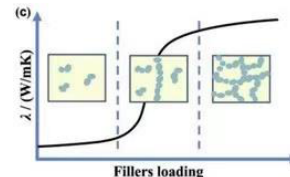
Figure 1. Thermal expansion and core burning of filling material in composite cross-arms ( a ) Cracking of a cross-arm sample; ( b ) Core burning of a cross-arm sample.